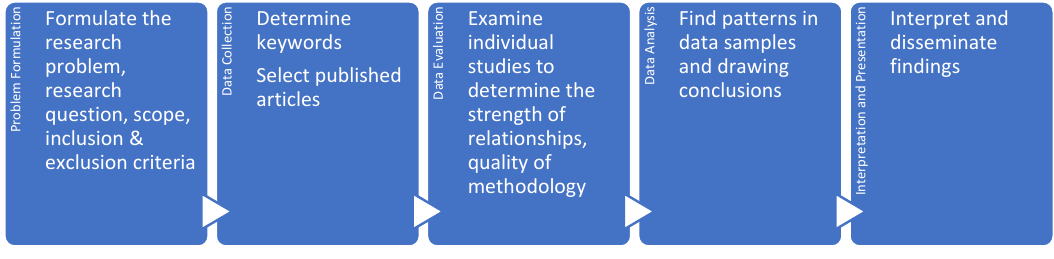
Fig. 4 Integrative approach review process (adopted from [42])